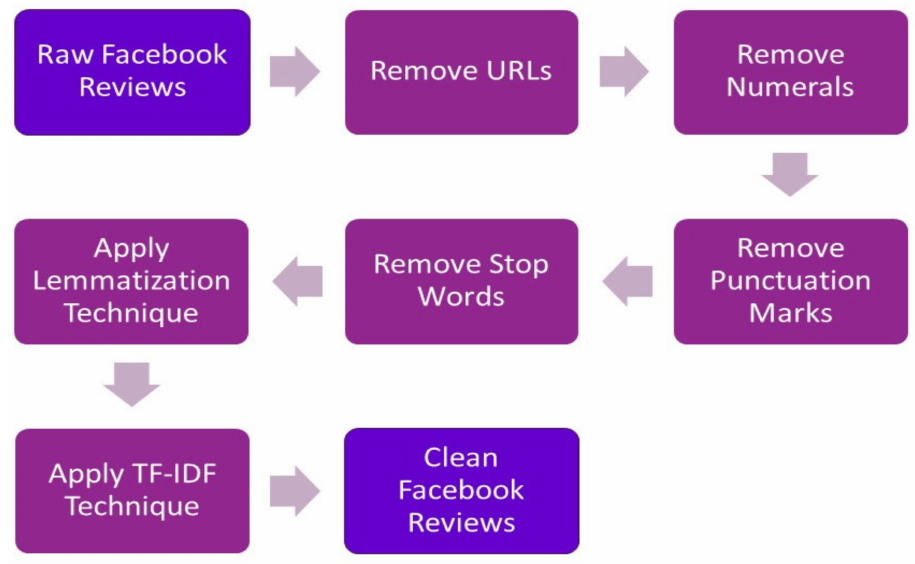
Figure 1. Text Preprocessing using natural language processing (NLP) techniques.